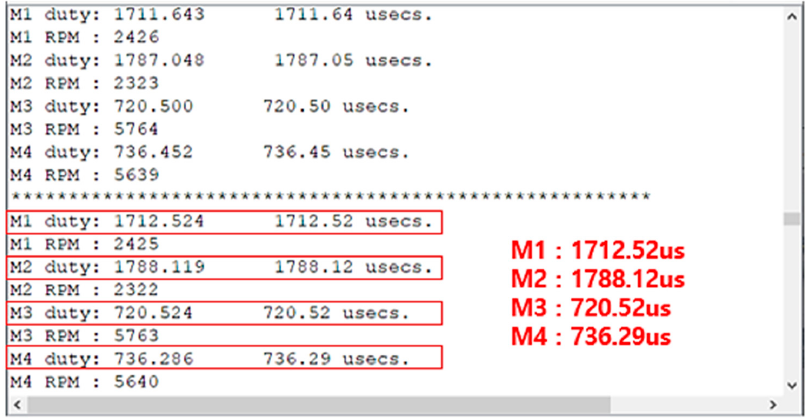
Figure 6. The infrared sensor signal measured with the controller.